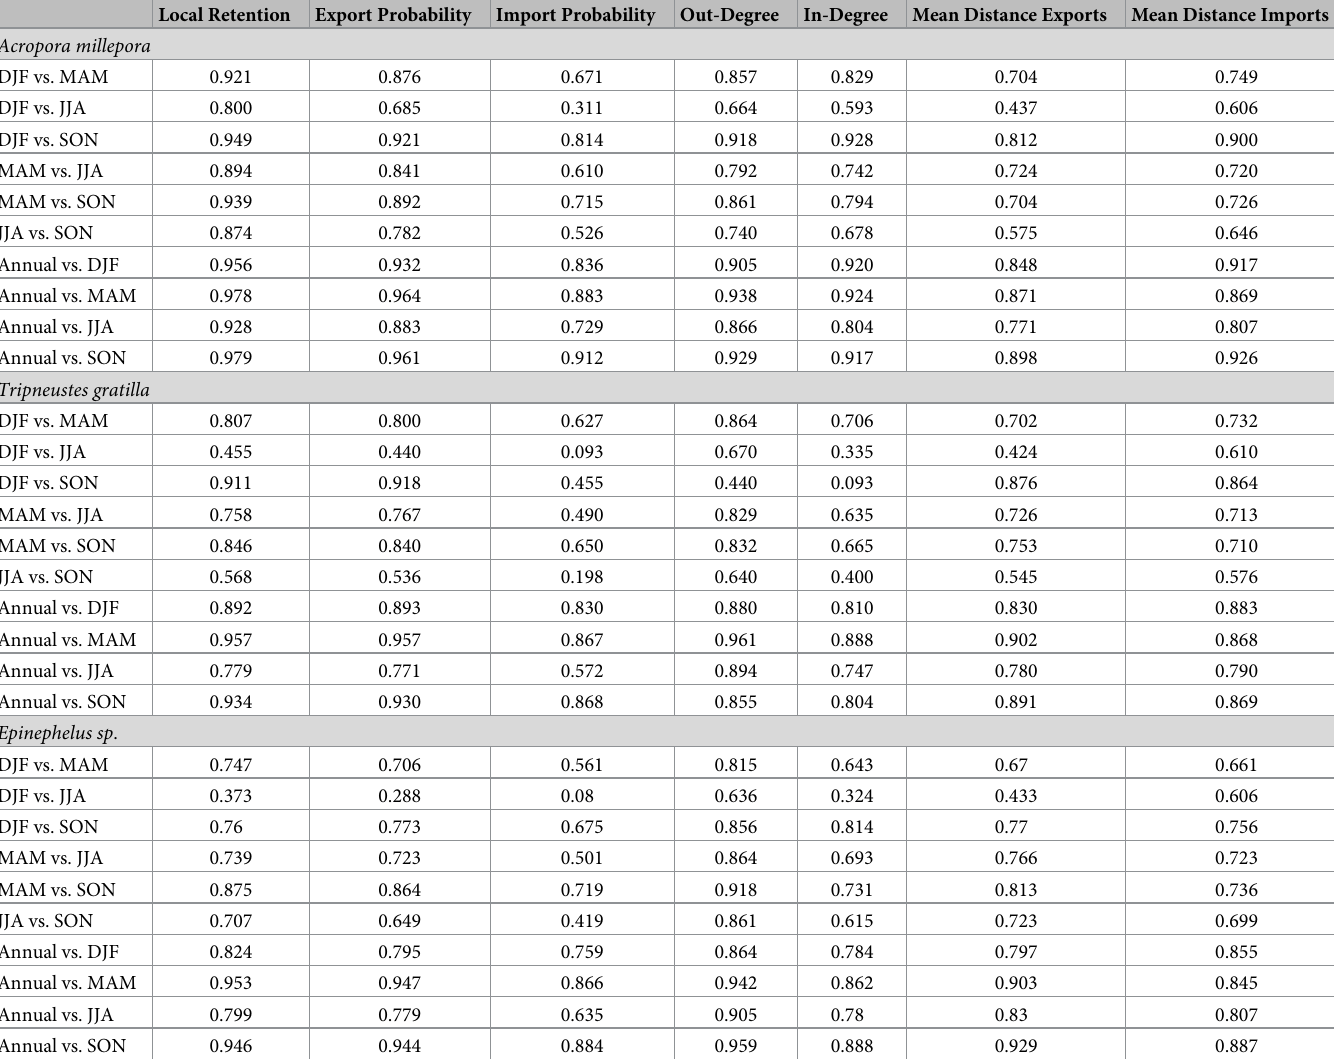
Table 3. Pearson correlation coefficients of the connectivity metric values of each reef cell between different temporal matrices for each model organism. All corre- lations were significant (p-values <